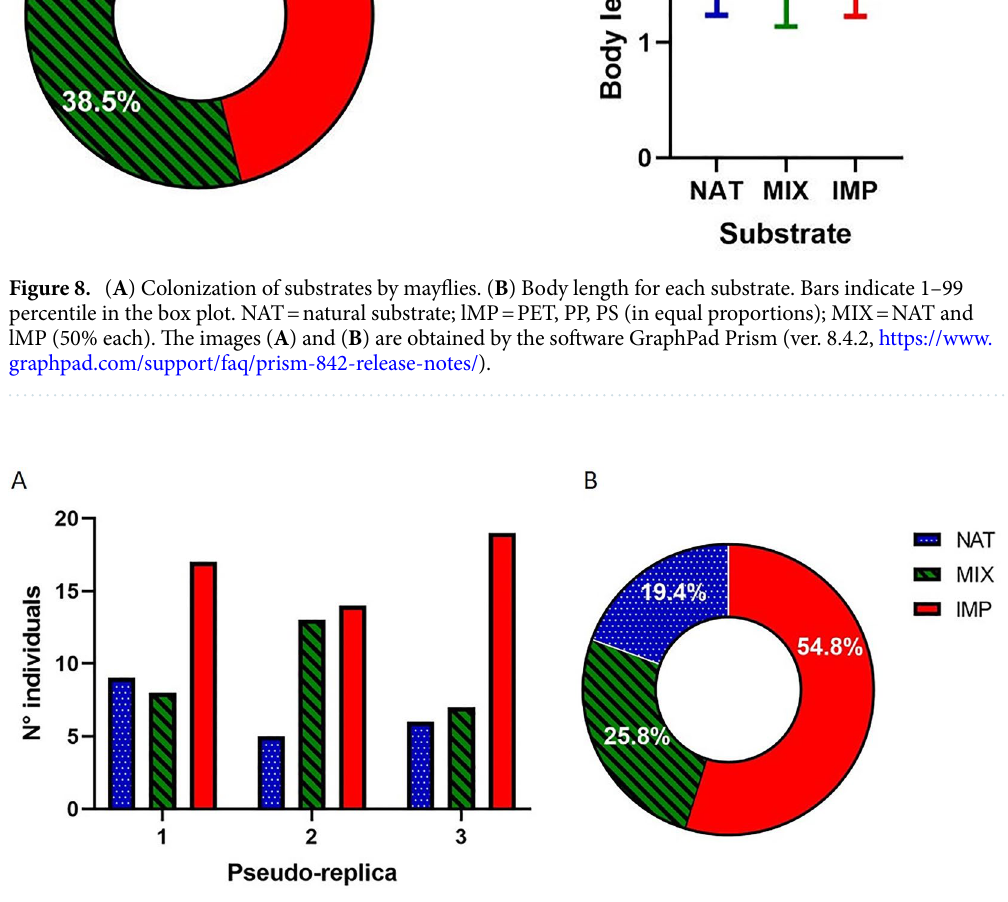
Figure 9. Results on occurrence of mayflies in each substrate for pseudo-replicas experiments: ( A ) results are shown for each pseudo-replica; ( B ) results of all pseudo-replicas are summed. Replica no. 1 indicate the first time of exposure. NAT = natural substrate; lMP = PET, PP, PS (in equal proportions); MIX = NAT and lMP (50% each). The images ( A ) and ( B ) are obtained by the software GraphPad Prism (ver. 8.4.2, https ://www.graph pad. com/suppo rt/faq/prism -842-relea se-notes